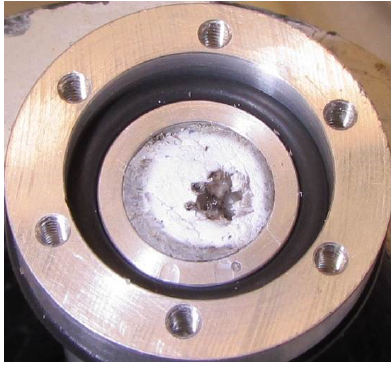
Figure 5. Photograph of BNNT material in the prototype target, showing material damage resulting from irradiation at 20- μ A beam current.